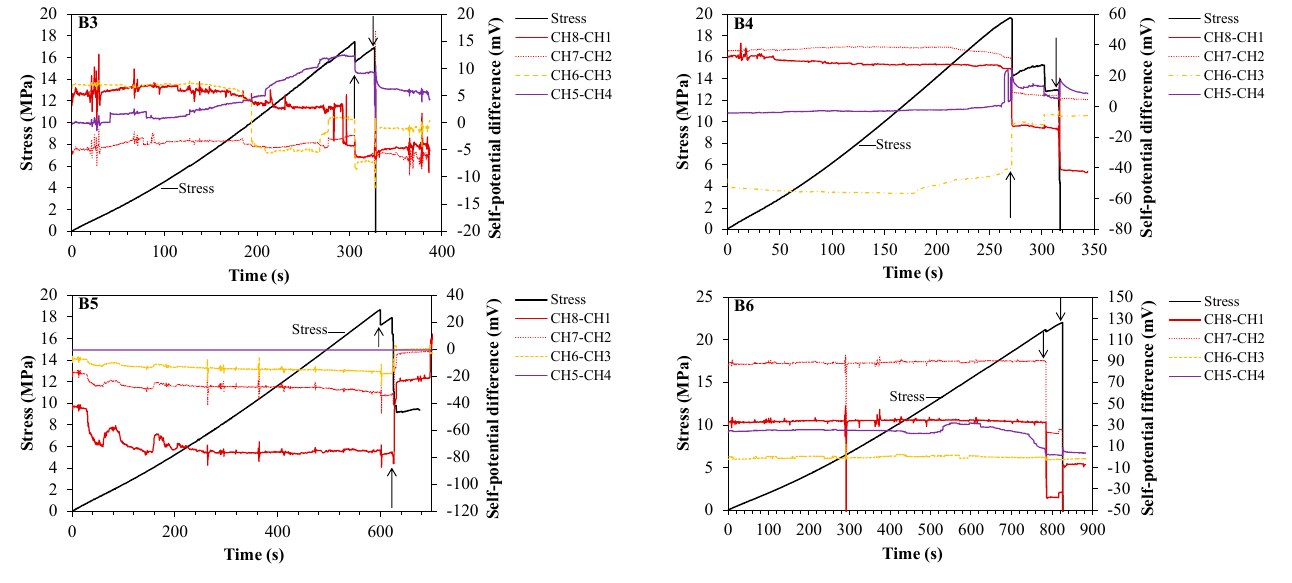
Figure 7. Curves of stress and axial self-potential difference with time of bituminous coal samples B1 to B6 under uniaxial loading.